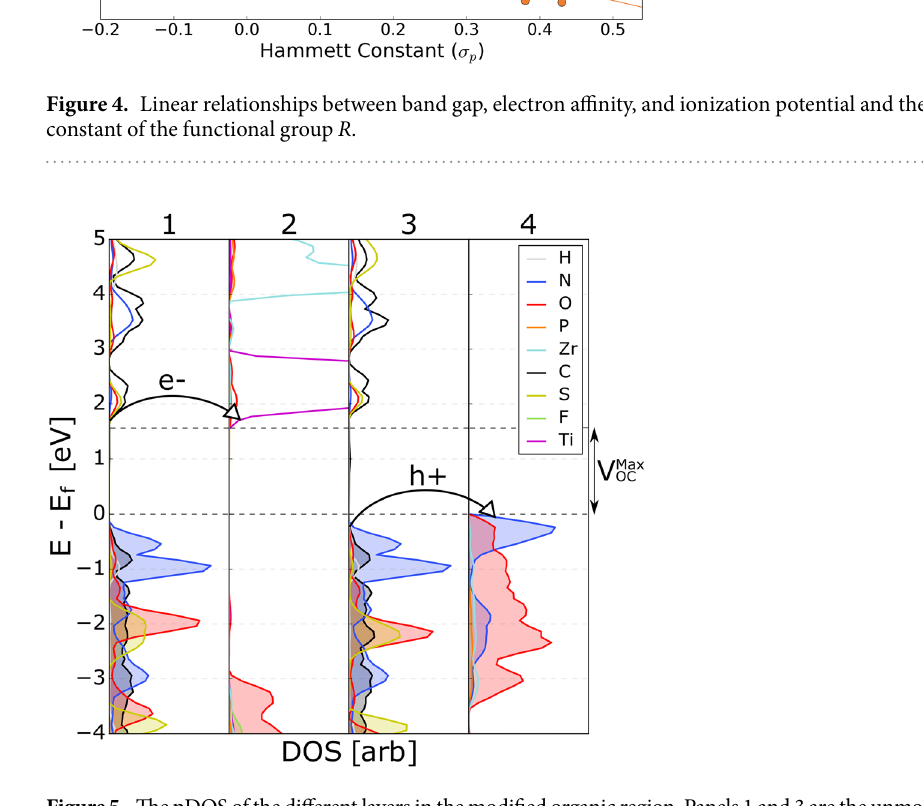
Figure 5. The pDOS of the different layers in the modified organic region. Panels 1 and 3 are the unmodified organic regions, panel 2 is